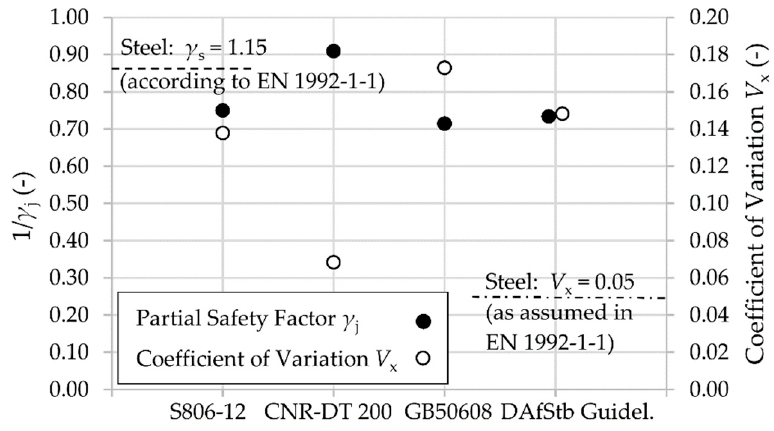
Figure 3. The partial safety factor γ j introduced in the designated standard or guideline and the corresponding coe ffi cient of variation V x .